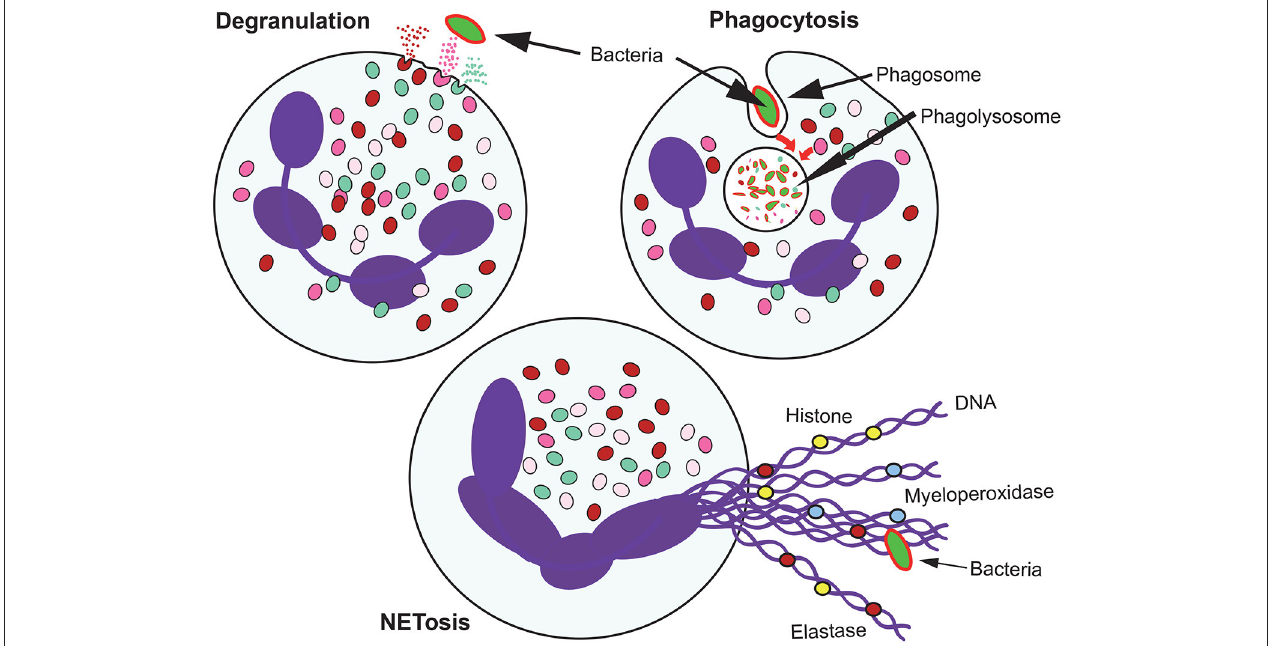
FIGURE 1 | Antimicrobial mechanisms of neutrophils. When neutrophils recognize microbial pathogens, they deploy different functions to destroy them. Phagocytosis involves the ingestion of the microorganism into a phagocytic vacuole that upon maturation becomes a phagolysosome. In this new organelle, the microorganism is destroyed by the action of low pH, and degrading enzymes. Neutrophils also degranulate and release to their environment the contents of their granules. When the microorganism is too large to be ingested, neutrophil can also produce extracellular traps (NETs) formed by DNA fibers and proteins from the